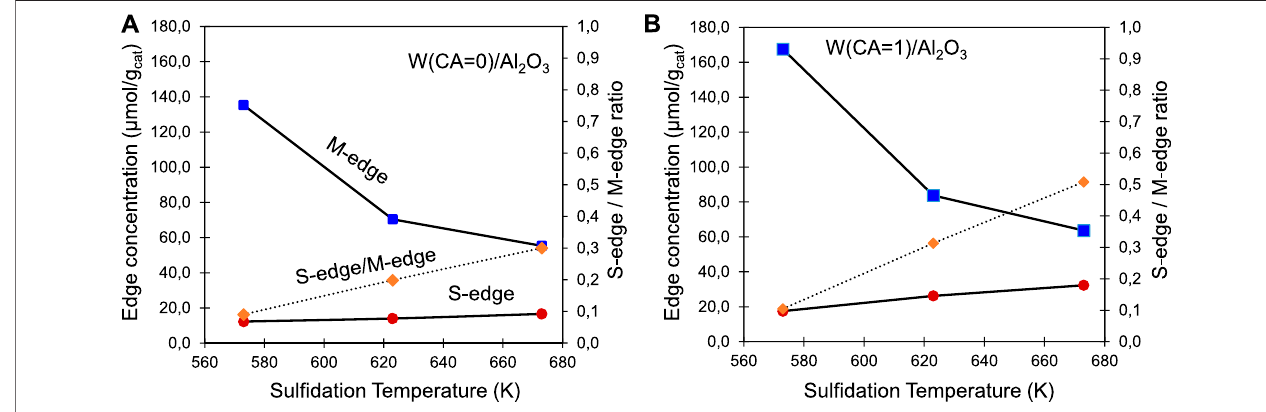
FIGURE 9 | M-edge and S-edge site concentration detected by low-temperature CO adsorption (solid line) and the ratio of S-edge/M-edge (dashed line) on (A) W(CA (cid:1) 0)/Al 2 O 3 and (B) W(CA (cid:1) 1)/Al 2 O 3 catalyst sul fi ded at different